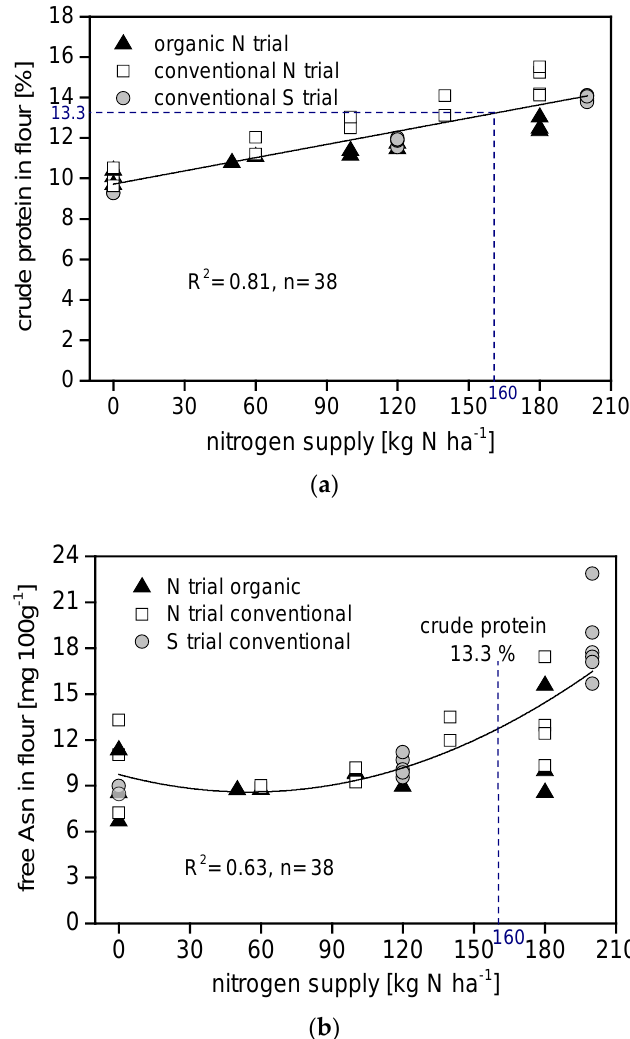
Figure 3. Impact of N supply on crude protein ( a ) and free Asn ( b ) content, separated by trial. The scattered line shows which N supply needed crude protein when E-wheat was reached and how much free Asn was formed.